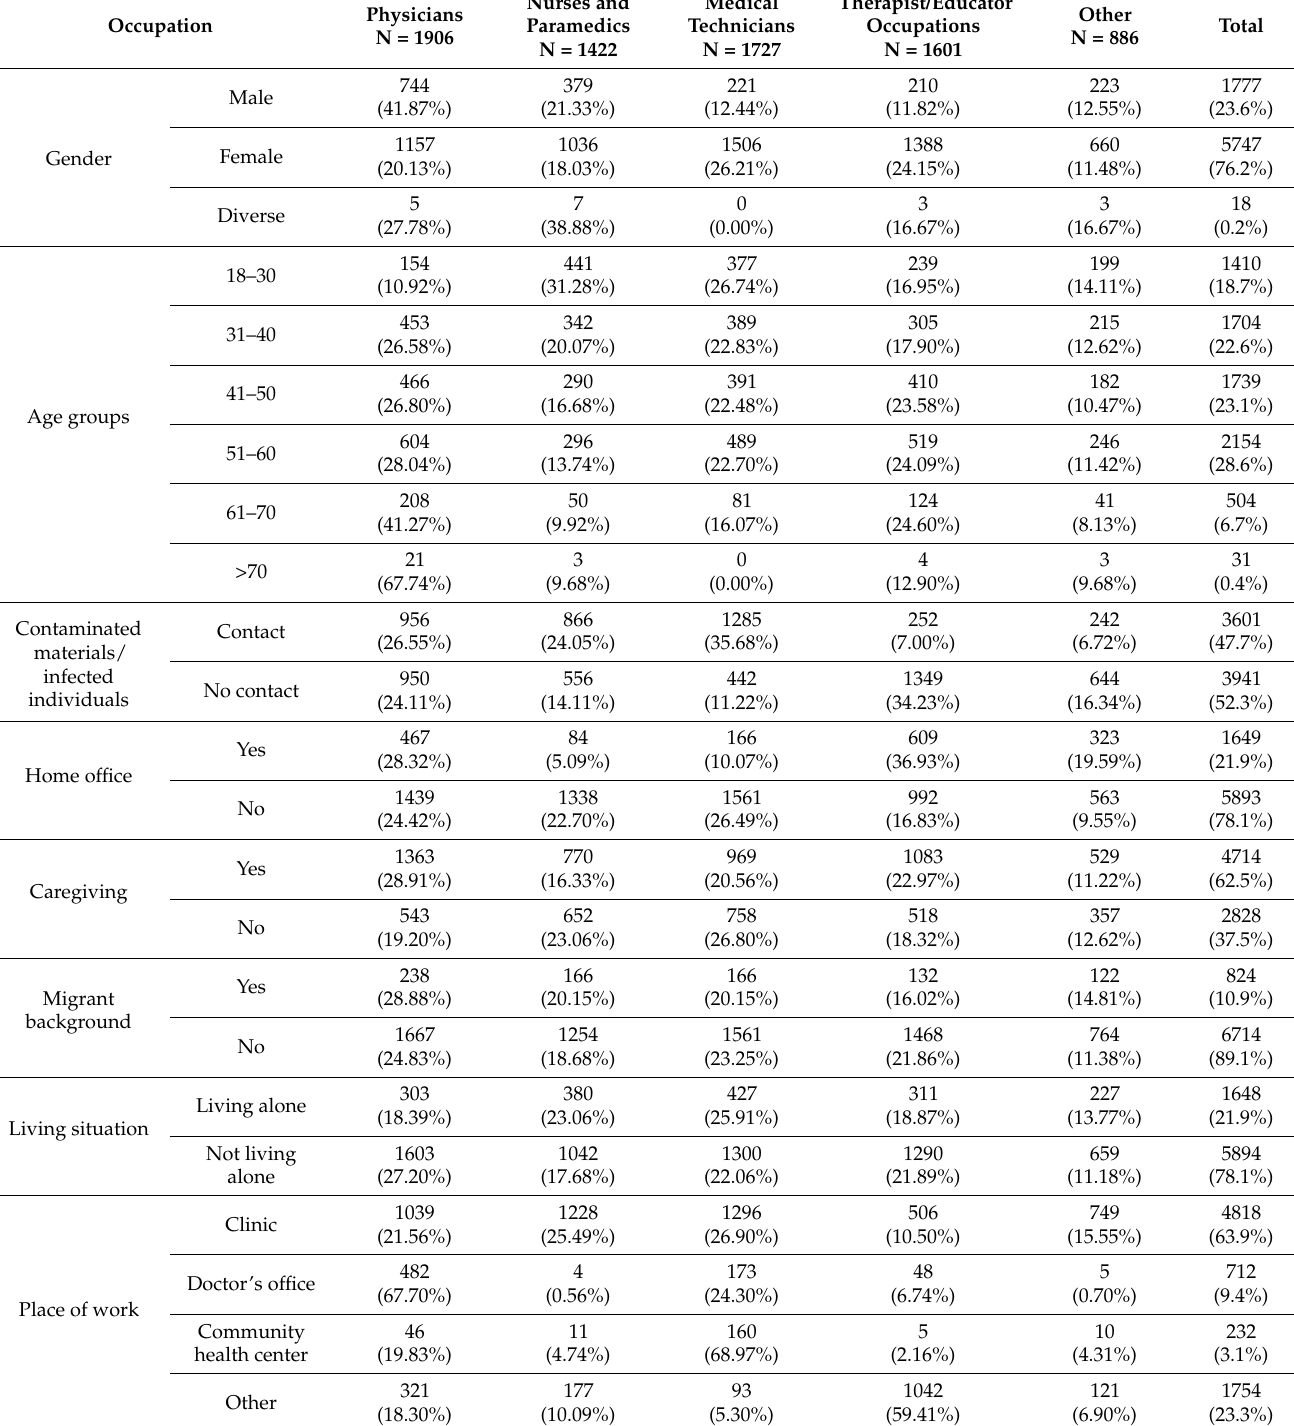
Table 1. Distribution of respondents to different occupational